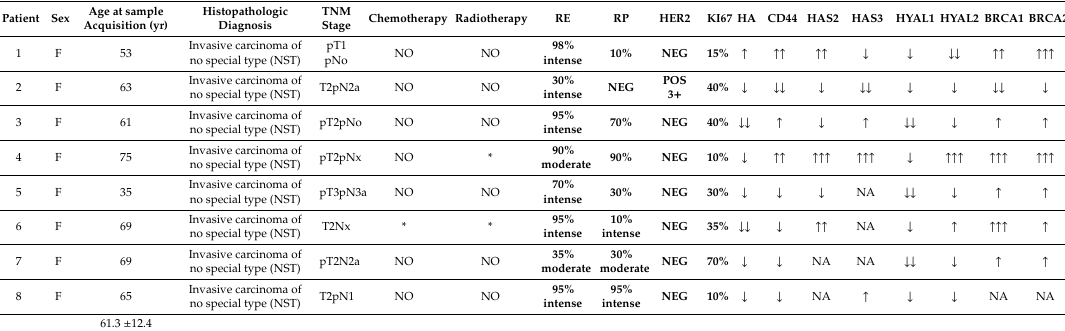
Table 4. Summary of the results for breast cancer patients.